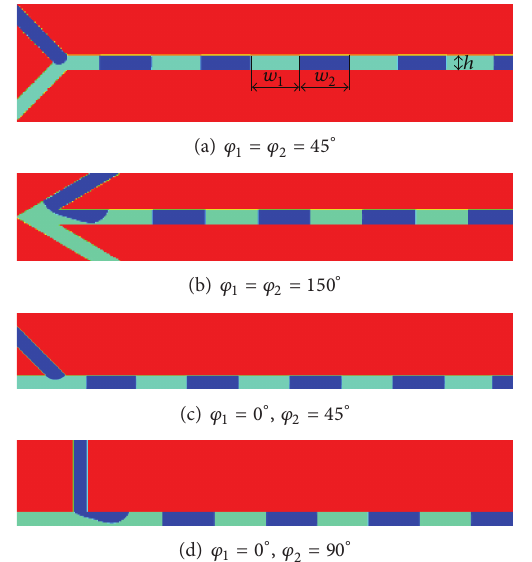
Table 1: Relative segment length 𝑤/ℎ at various inclined angles